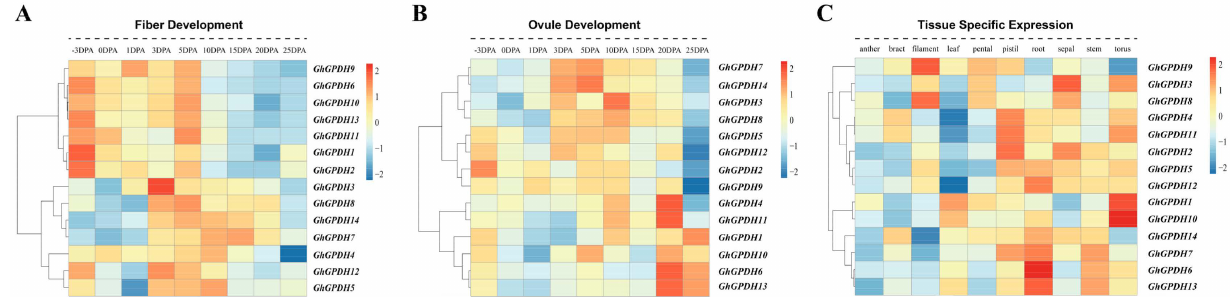
Figure 6. Transcriptional expression profiles of GPDHs in ovules, fibers and tissues of G. hirsutum at different developmental stages.